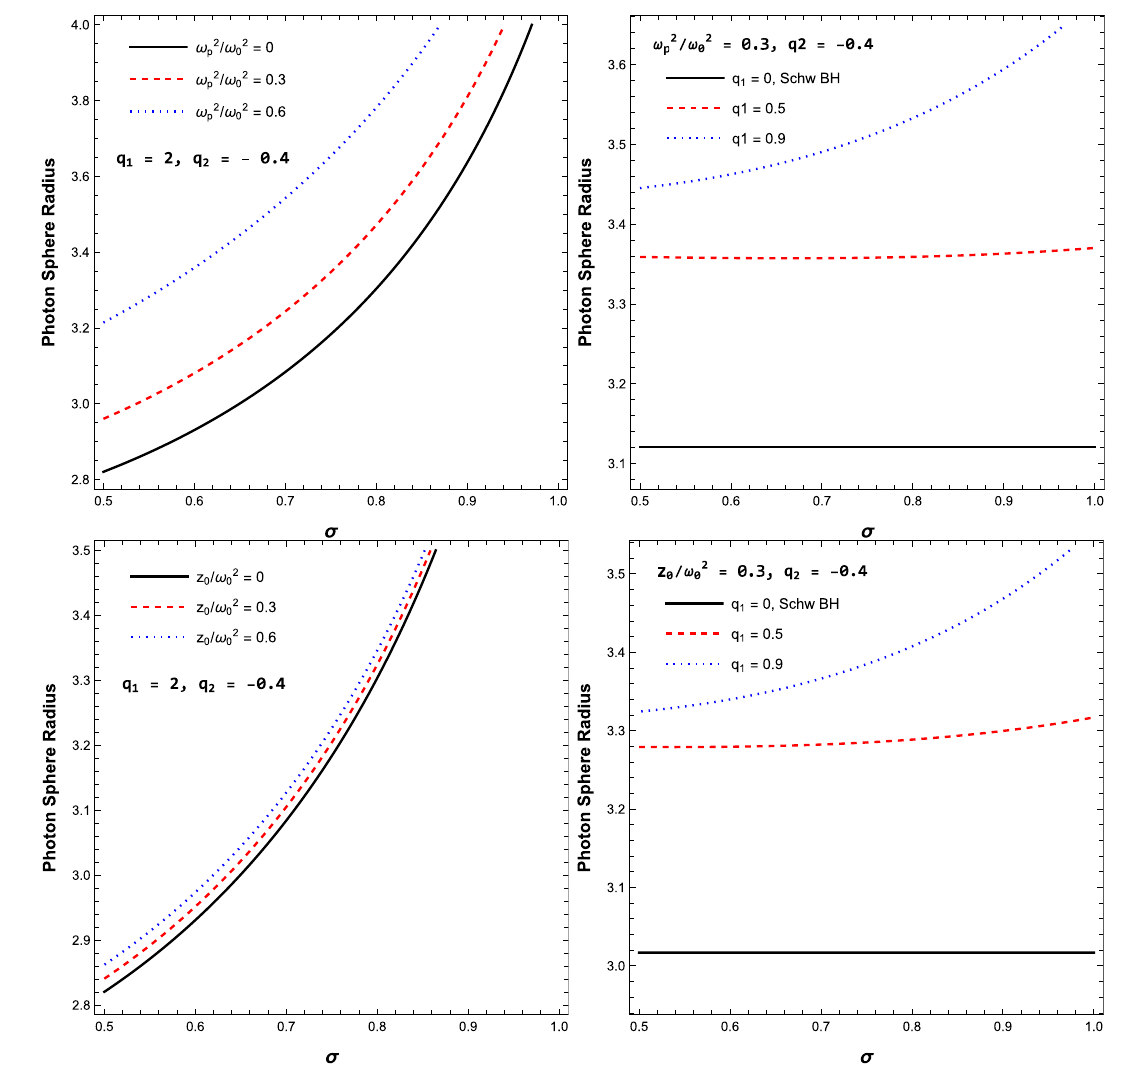
Fig. 10 The dependence of photon sphere radius on σ for selected values of q 1 and q 2 in uniform (upper panels) and non-uniform (lower panels) plasma. In the left panels q 1 and q 2 are fixed while plasma fre-